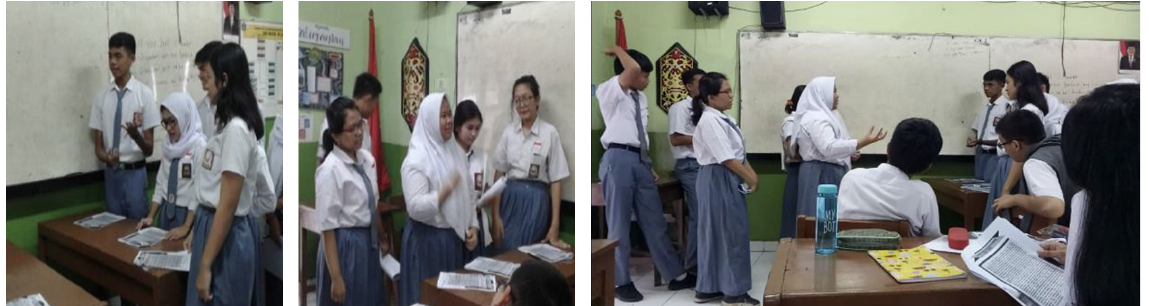
Figure 3. The Debate on the Second Article “Are There Benefits of